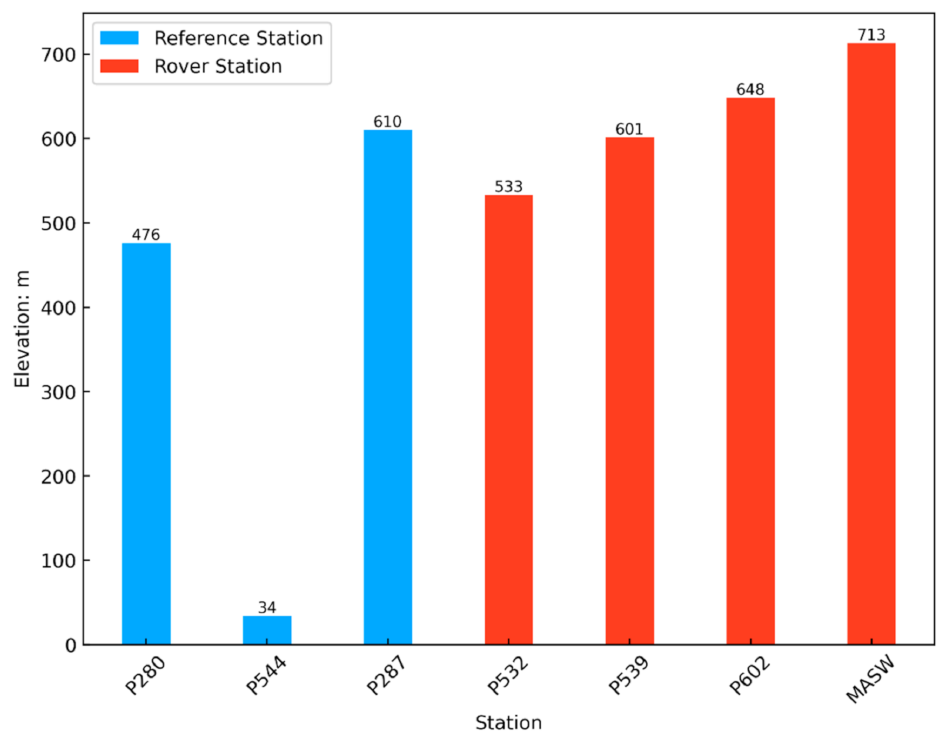
Figure 4. The elevation distribution of the stations in Dataset